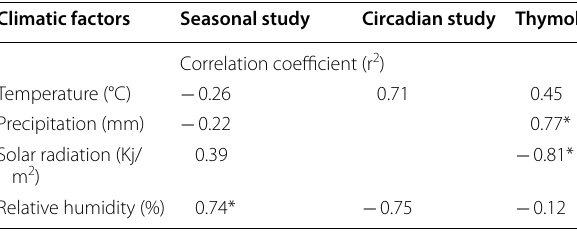
Table 1 Correlation between climatic factors and seasonal and circadian studies, based on the yields of L. thymoides oils and thymol content